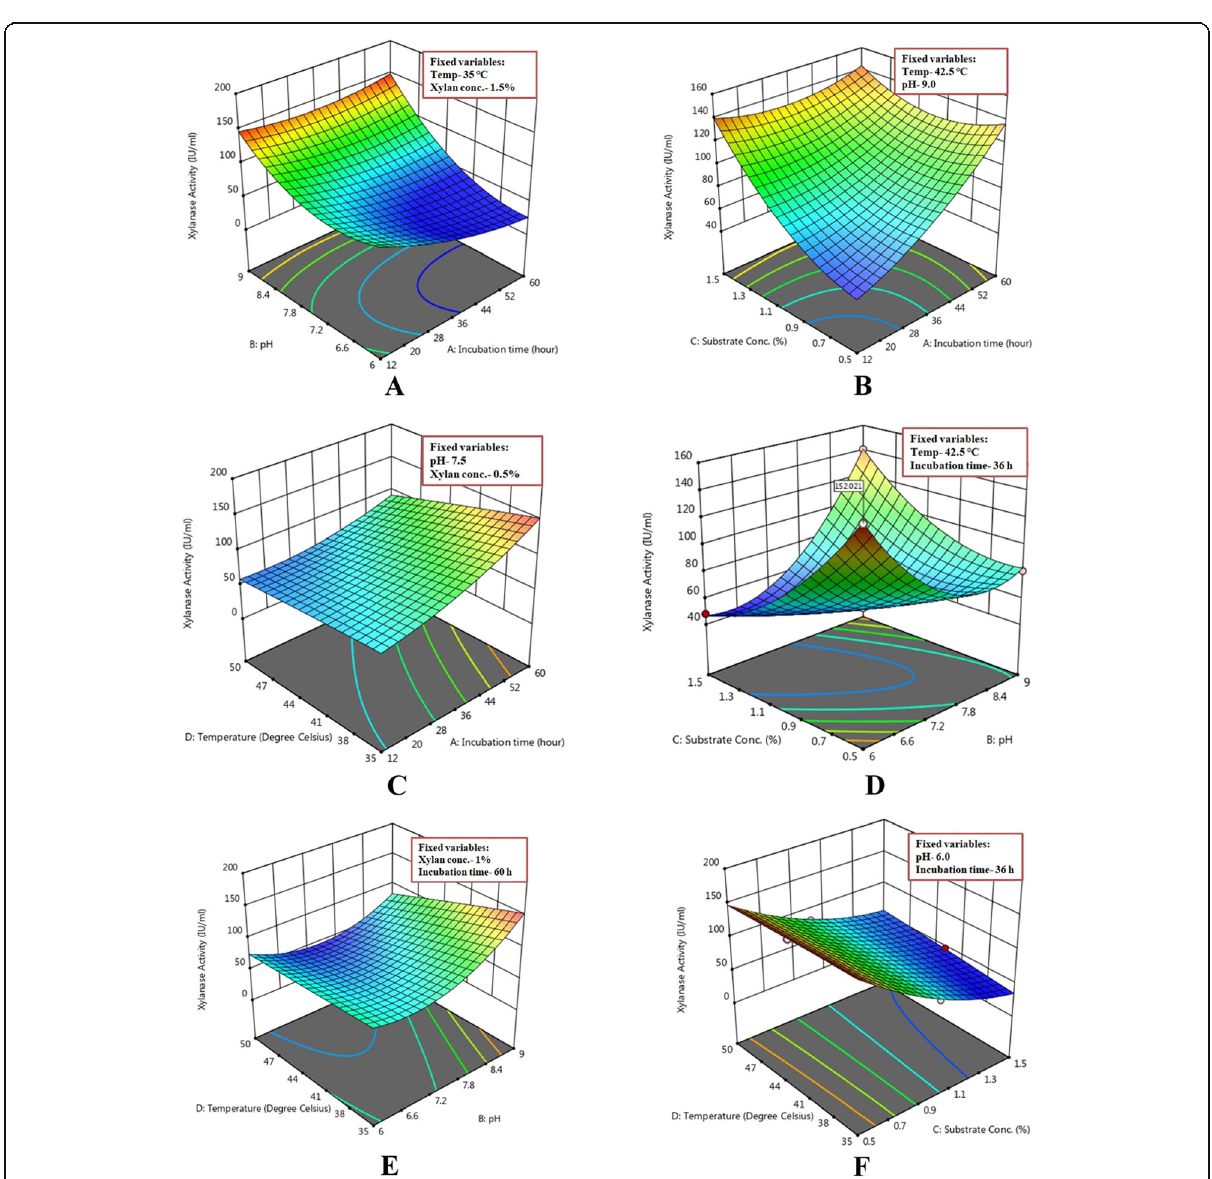
Fig. 8 Response surface graph of xylanase activity of the xylanolytic bacterium Pseudomonas mohnii with respect to different experimental factors a vs. pH, incubation time; b vs. substrate conc., incubation time; c vs. temperature, incubation time; d vs. substrate conc., pH; e vs. temperature, pH; and f vs. temperature, substrate